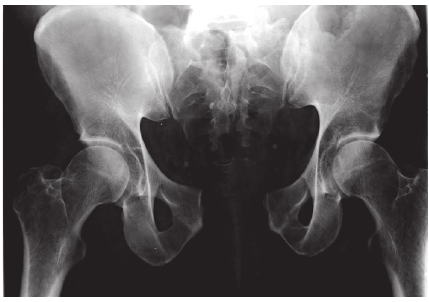
Figure 1: Presenting pelvis injury